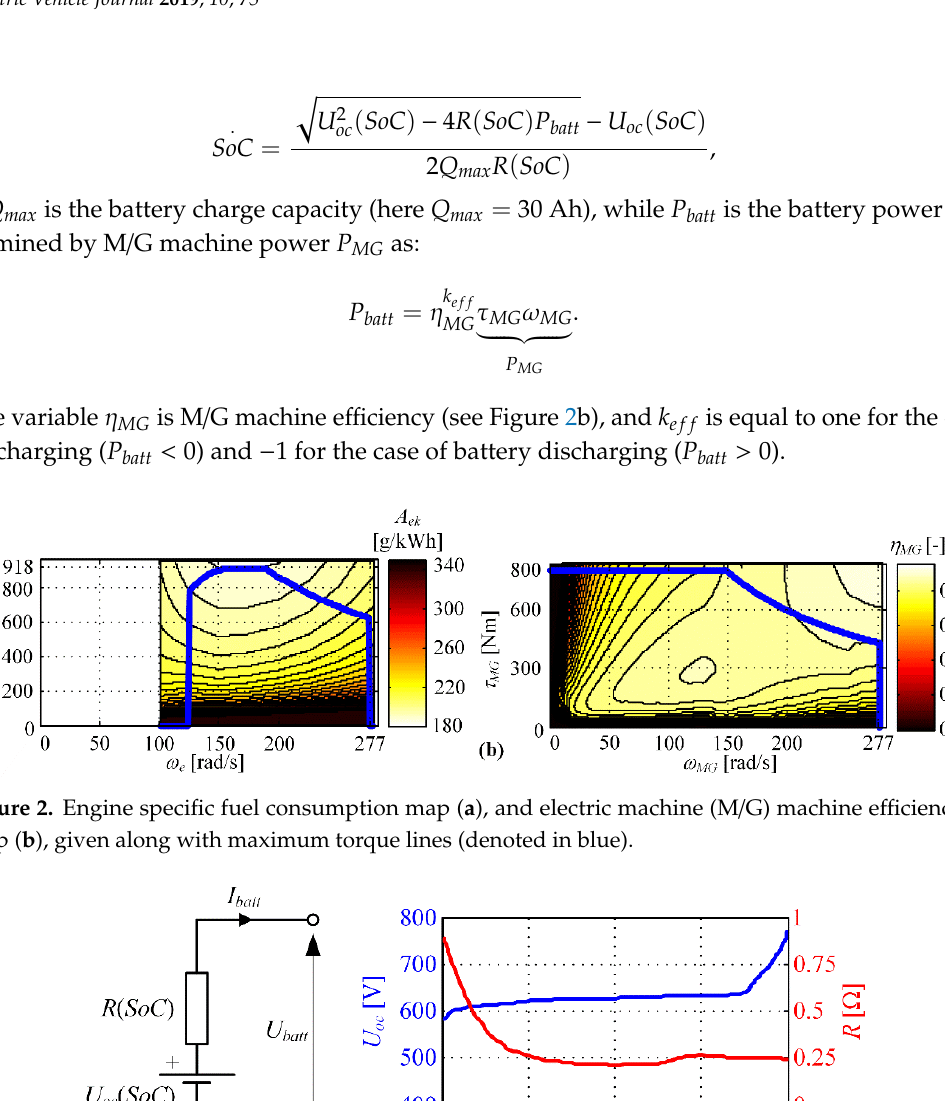
Figure 3. Battery equivalent circuit ( a ), and dependencies of open-circuit voltage and internal battery resistance with respect to battery state-of-charge (SoC) for a considered lithium iron phosphate battery ( b ).